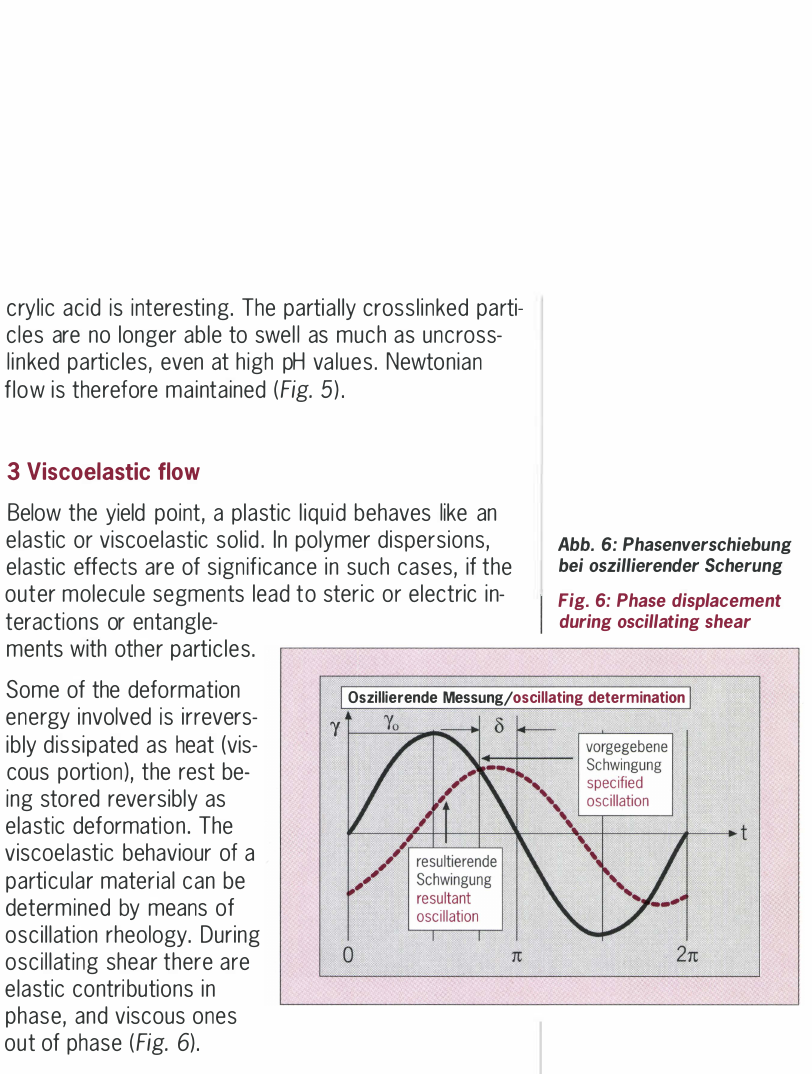
Tabelle 1 : Verwendete Formelzeichen at ion Table 1: E xp l an of symbols